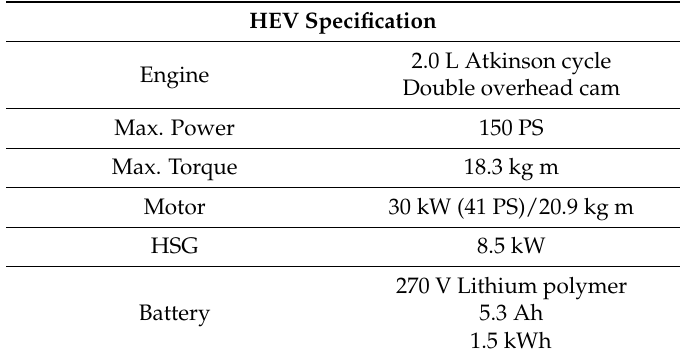
Table 1. Specifications of HEV used in this study.